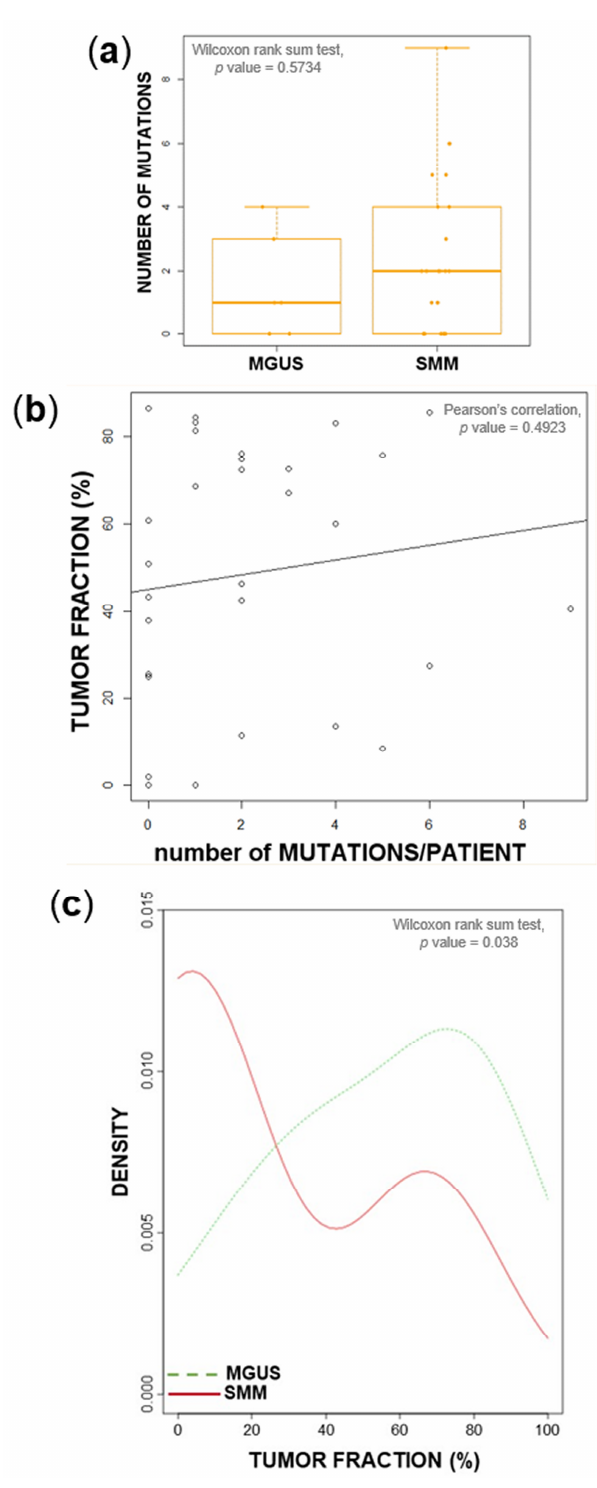
Figure 1. Relationship between the tumor fraction, mutation burden, and disease stage. ( a ) Number of detected mutations in six monoclonal gammopathy of undetermined significance (MGUS) and 25 smoldering multiple myeloma (SMM) patients. ( b ) The number of called mutations in genomic DNA from CD138 + bone marrow (BM) plasma cells of each patient did not correlate with the estimated tumor fraction. ( c ) Density plot of estimated tumor fractions in six MGUS and 25 SMM patients.